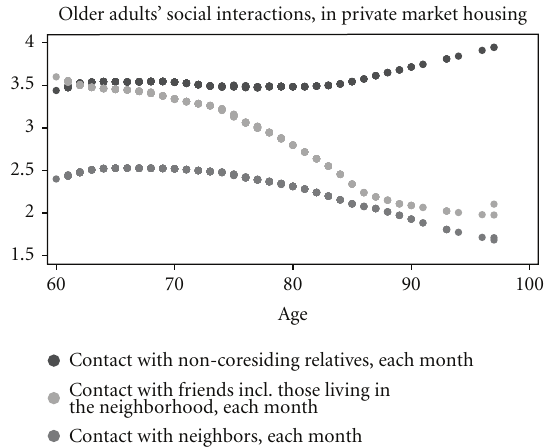
Figure 1: These locally weighted bivariate regressions do not con- trol for health.